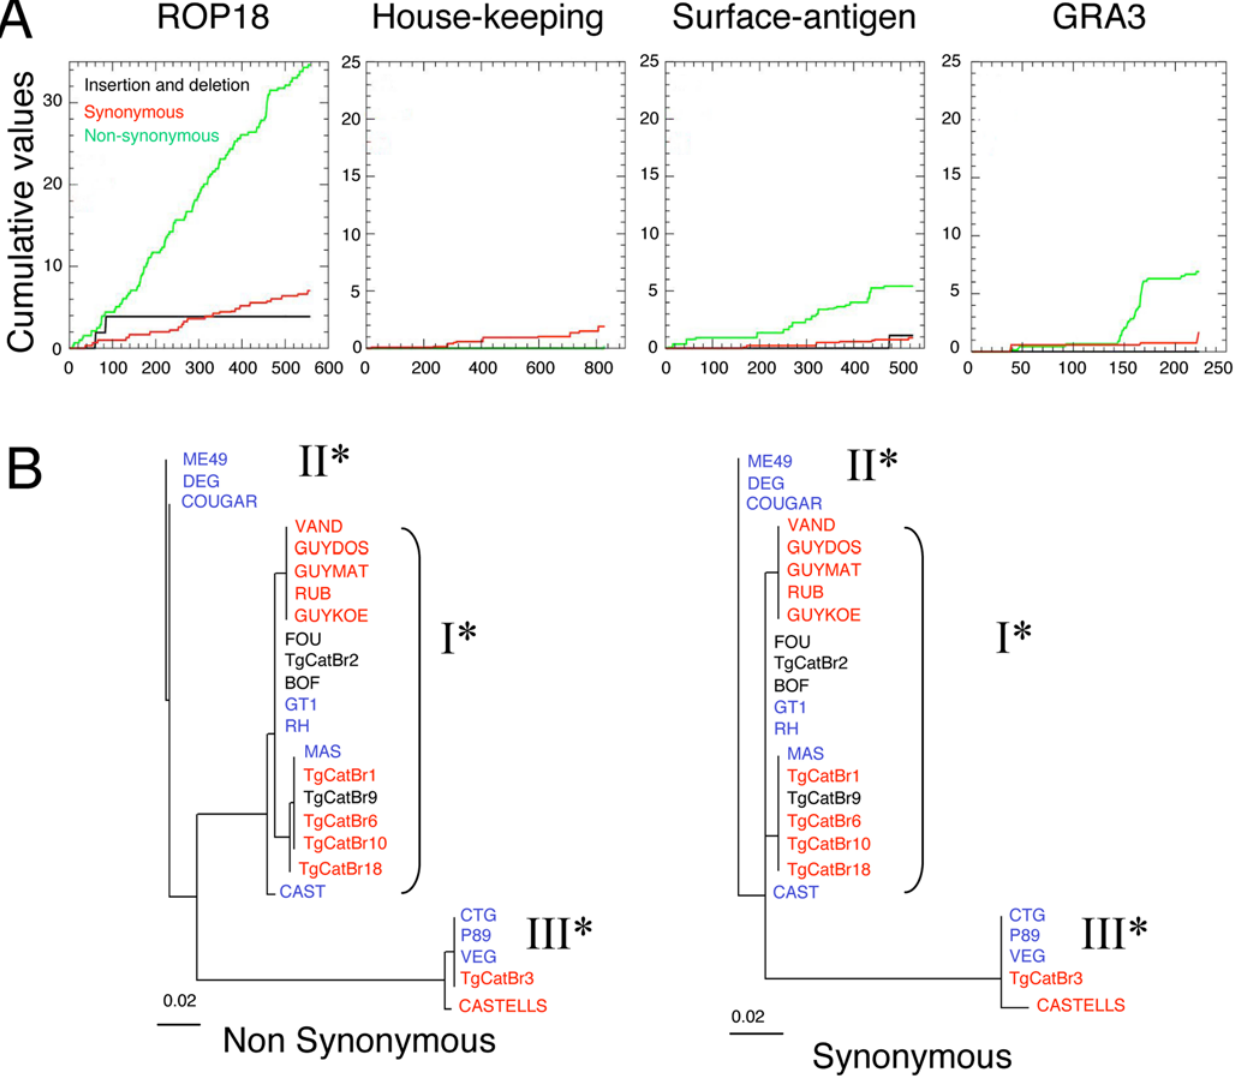
Figure 3. Polymorphism of ROP18 between major alleles. A) Cumulative nonsynonymous (NS) and synonymous (S) polymorphisms in ROP18 are significantly higher than surface antigens, GRA3 , or housekeeping genes. B) Phylogenetic analysis of ROP18 analyzed separately for nonsynonymous changes (left) and synonymous changes (right) reveals a strongly asymmetric pattern. The major difference between types I* and II* is due to nonsynonymous changes. Scales=substitutions/site.